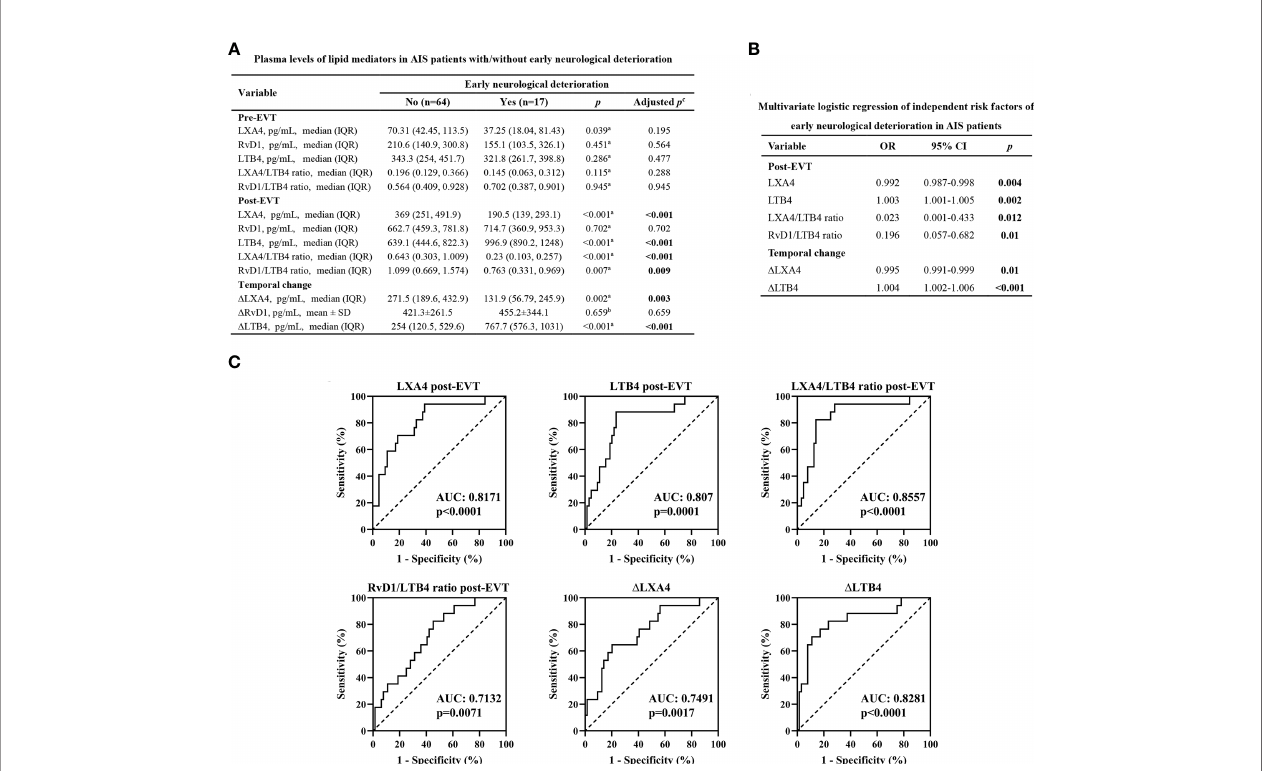
FIGURE 2 | Plasma levels of lipid mediator parameters and END. (A) Plasma levels of lipid mediator parameters in EVT-treated AIS patients with or without END. a Data were presented as median and IQR, and were analyzed by Mann-Whitney U test. b Data were presented as mean ± SD, and were analyzed by independent- samples t-test. c False Discovery Rate (FDR)-correction was conducted to control the error rate under multiple testing. (B) Multivariate logistic regression of independent risk factors of END. Confounding factors: age and gender. (C) Receiver operator characteristic (ROC) curve analyses for lipid mediator parameters to predict END after successful EVT in patients with AIS. OR, odds ratio; CI, con fi dence interval. AUC, area under the